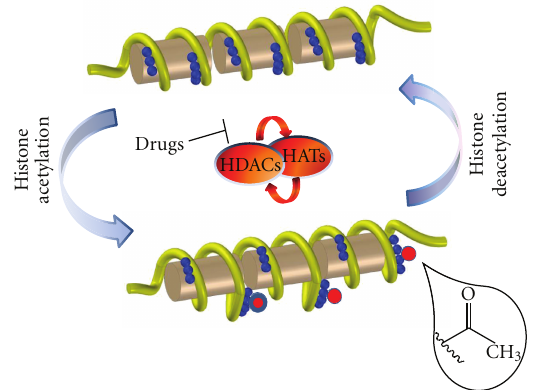
Figure 1: Physical and Functional interaction between HATs and HDACs regulates gene expression; HATs and HDACs enzymes are simultaneously present on the regulatory regions of target genes, and their opposing activities play a pivotal role for transcriptional competence. The use of selective HDAC inhibitors allows to restore the acetylation balance lost in several pathological